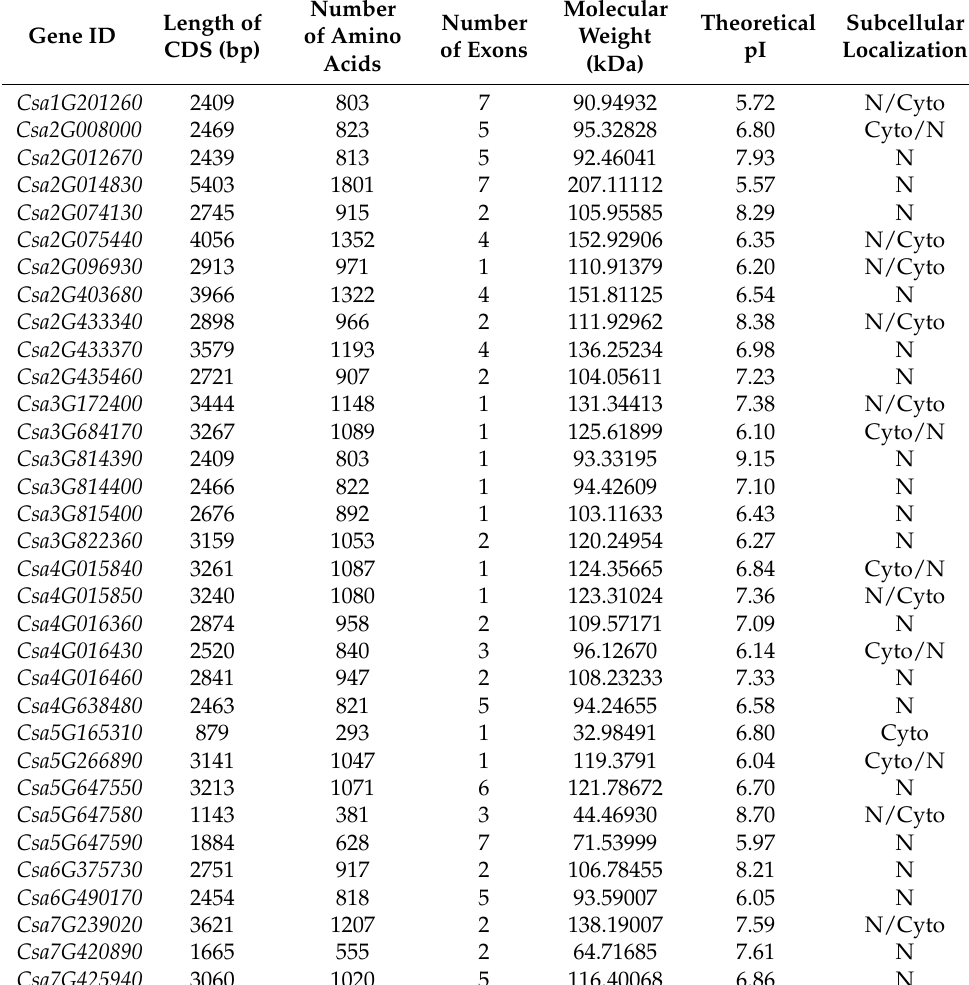
Table 1. Characteristics of the CNL family of genes and the corresponding proteins in cucum- ber